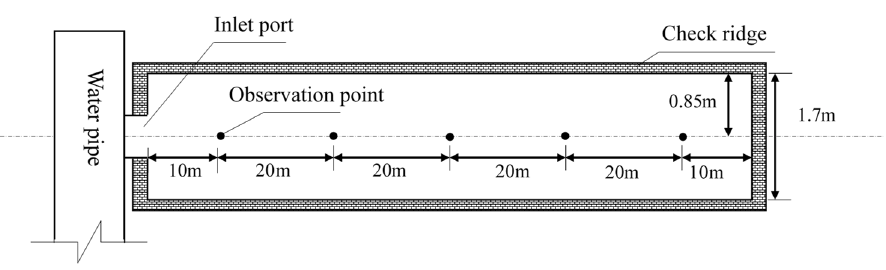
Figure 4. Observation point